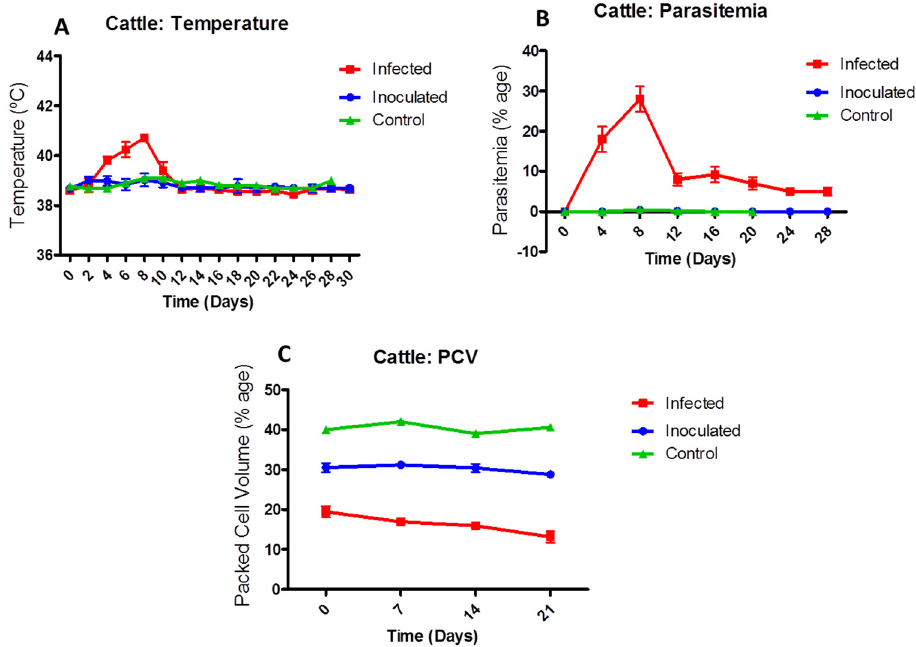
Figure 3. The effect of Babesiosis on body temperature ( A ), parasitaemia ( B ) and packed cell volume ( C ) in B. bigemina -inoculated and -infected calves.